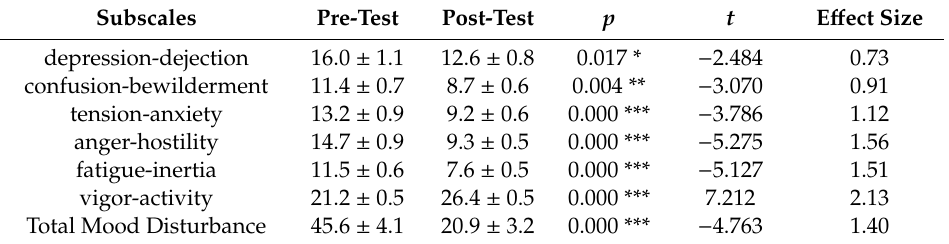
Table 9. E ff ect of Rocky Leaf Prints on Profile of Mood State (POMS).